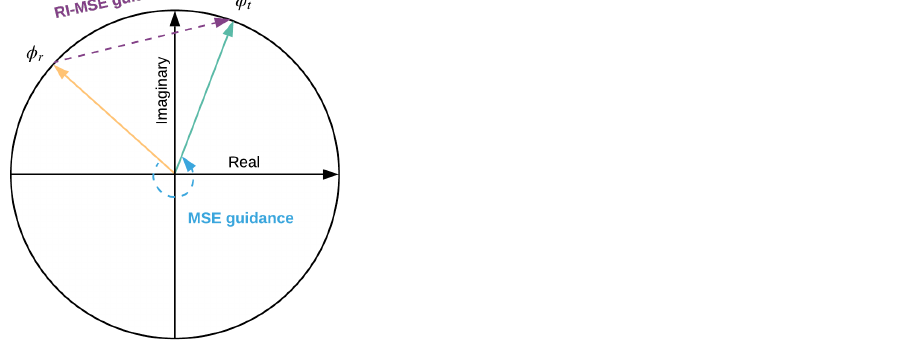
Figure 1. Illustration of phase jump and compassion real and imaginary MSE (RI-MSE) and mean square error (MSE) objective functions.